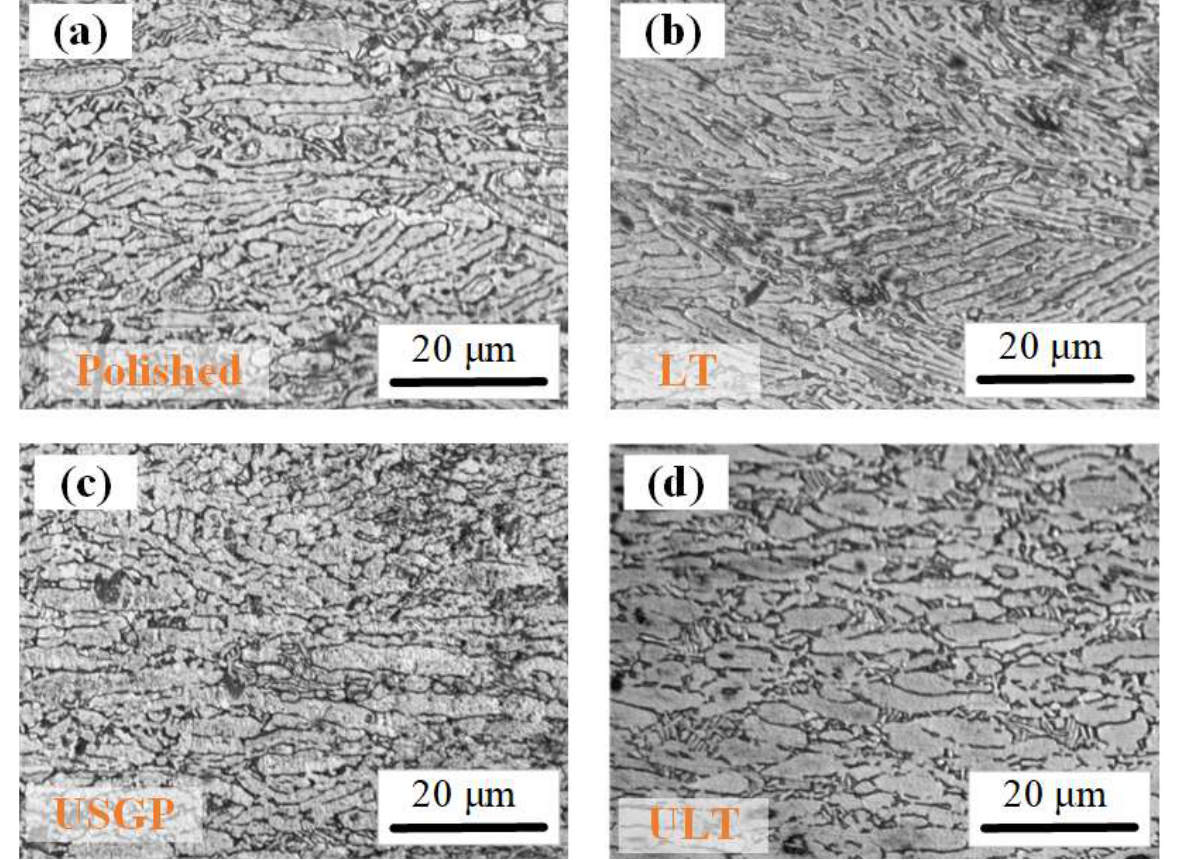
Figure 6. Cross-sectional microstructures of polished ( a ), LT ( b ), USGP ( c ), and ULT ( d ) samples.